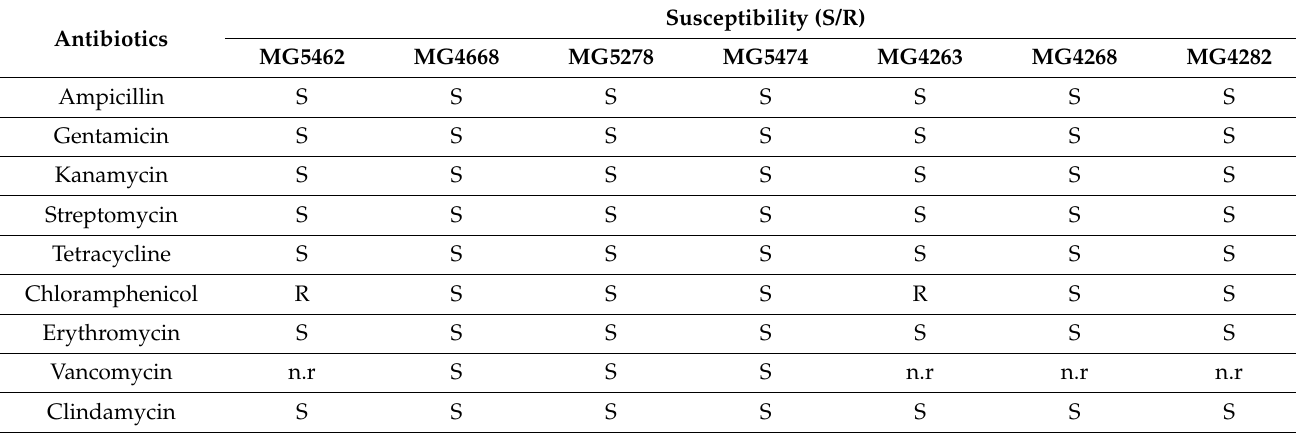
Table 3. Antibiotic susceptibility of LAB